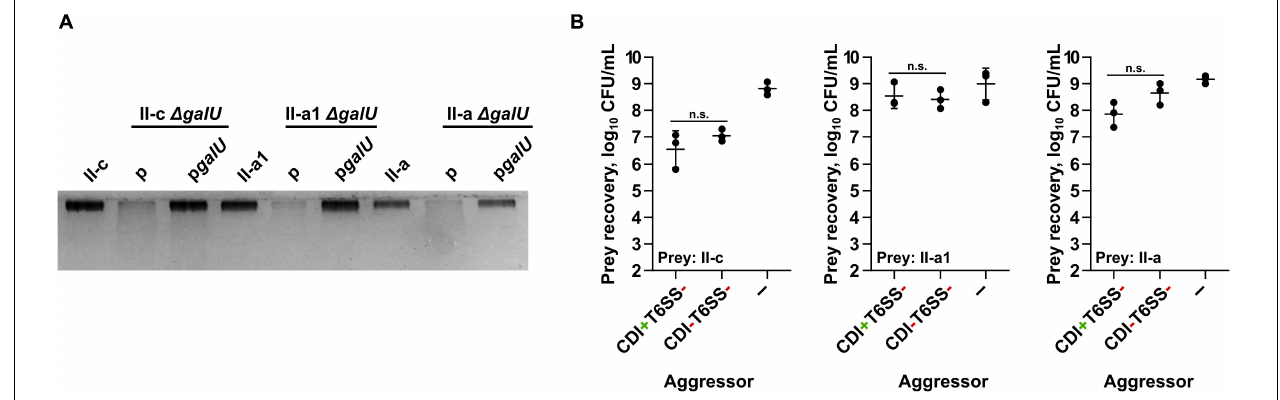
FIGURE 1 | (A) Evaluation of capsular polysaccharide production by clinical strains II-c, II-a1, and II-a, their galU mutants, and galU mutants complemented with the wild-type galU gene. A part of 12.5% SDS-PAGE gel stained with Alcian Blue is shown. (B) Quantitative evaluation of inter-bacterial competition. Graphs show recovered numbers of A. baumannii clinical strains II-c, II-a1, and II-a after being premixed with an excess of an aggressor at the aggressor:prey ratio of 10:1. Competitions were performed with the following A. baumannii V15 mutants used as the aggressors: (cid:49) bfmRS (cid:49) hcp (CDI + T6SS − ), (cid:49) bfmRS (cid:49) hcp (cid:49) cdi V15 (CDI − T6SS − ). E. coli DH5 α was used as a negative non-competitive control to enumerate bacteria numbers if there was no competition. Error bars represent standard deviation. Horizontal lines represent mean value. Values were calculated from three independent experiments. n.s., not